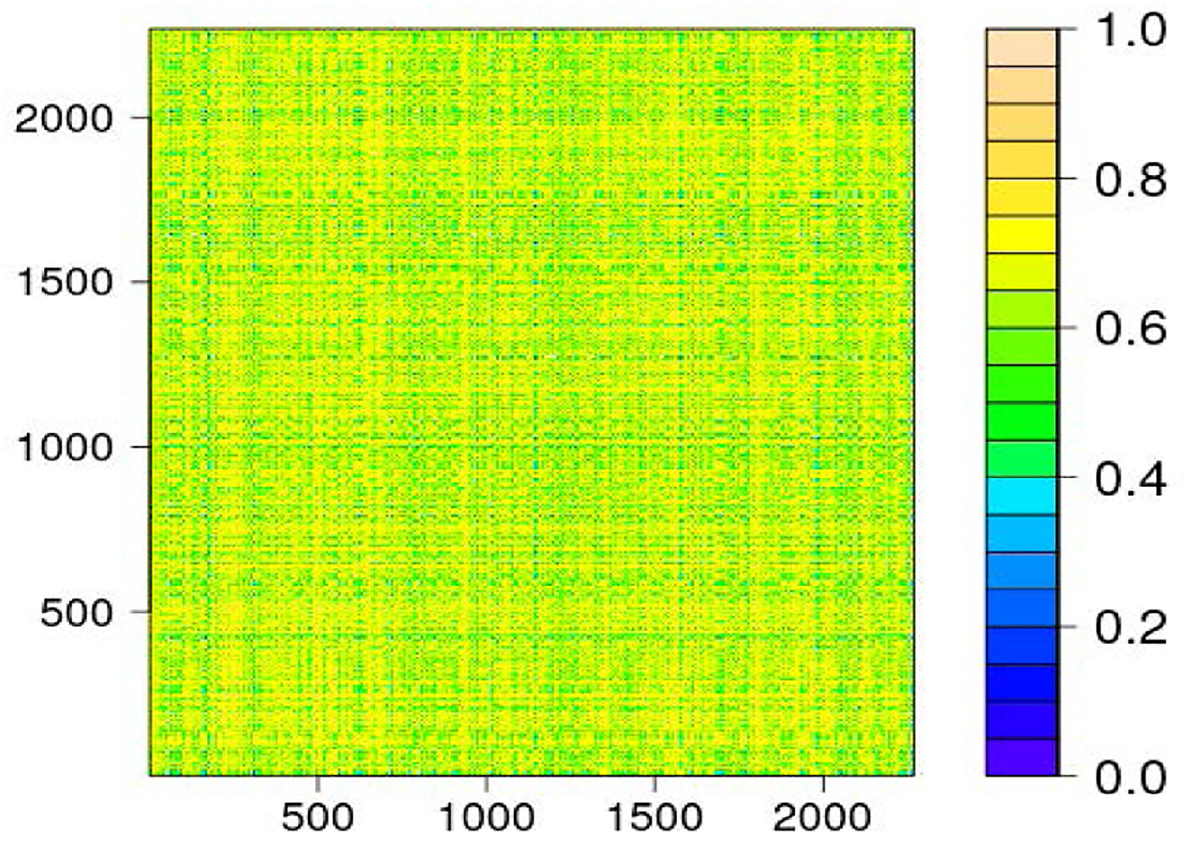
Fig 4. Heatmap of correlation between highly correlated genes.